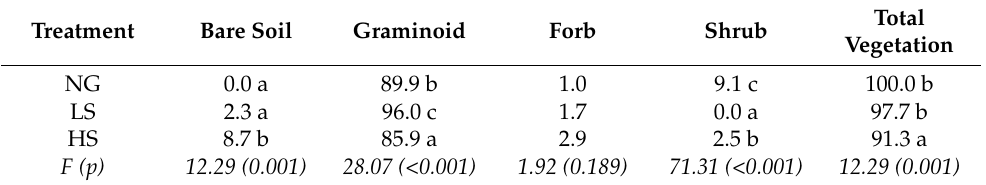
Table 1. One-way analyses of variance (ANOVAs) for bare soil and vascular plant ground cover (%) at the pre-burn ( t 0) time, classified according to their life-form (graminoid, forb, shrub) and for the total vegetation, where grazing (NG = non-grazed, LS = low stocking rate, HS = high stocking rate) is the main analysis factor. Bare soil was log (X + 1) transformed to accomplish the assumptions of ANOVA, but non-transformed data are shown.